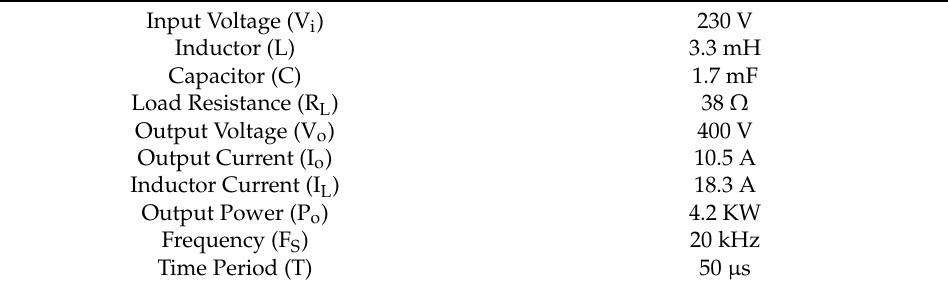
Table 3. Boost Converter